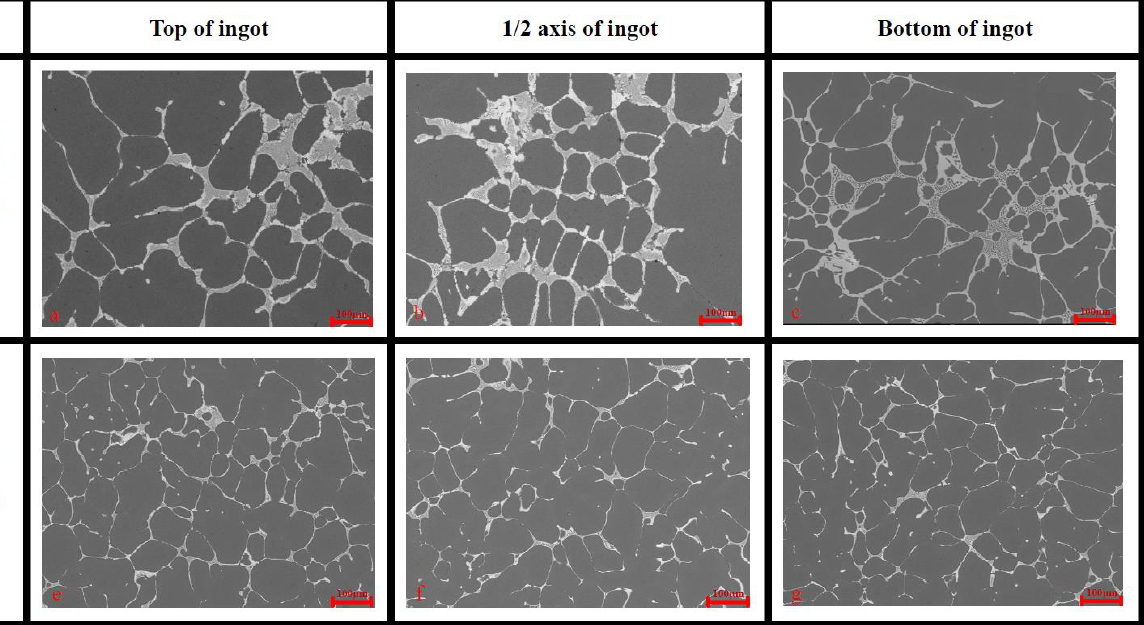
Figure 5. Morphology and distribution of secondary phases and precipitated particles at different sampling positions in ingots formed with and without USMT.